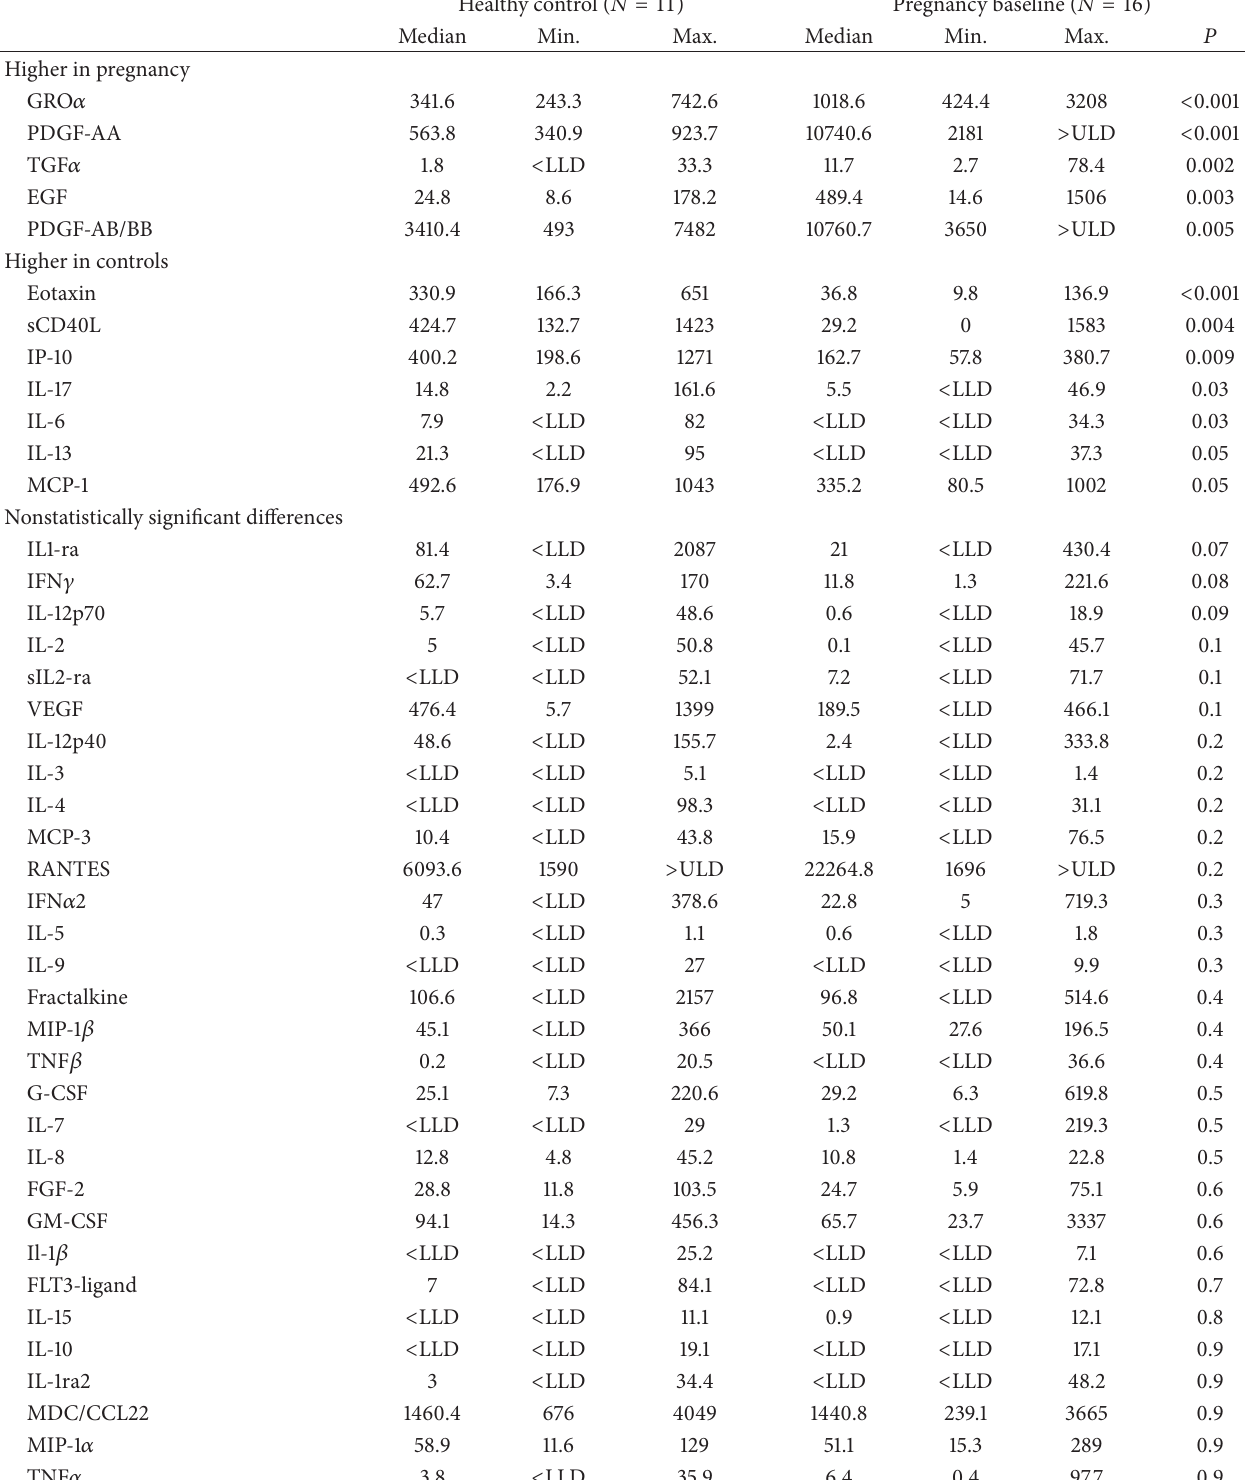
Table 1: Comparison of protein concentrations (pg/mL) of growth factors and cytokines between controls and baseline pregnancy samples. Healthy control ( 𝑁 = 11 ) Pregnancy baseline ( 𝑁 = 16 ) Median Min. Max. Median Min. Max.